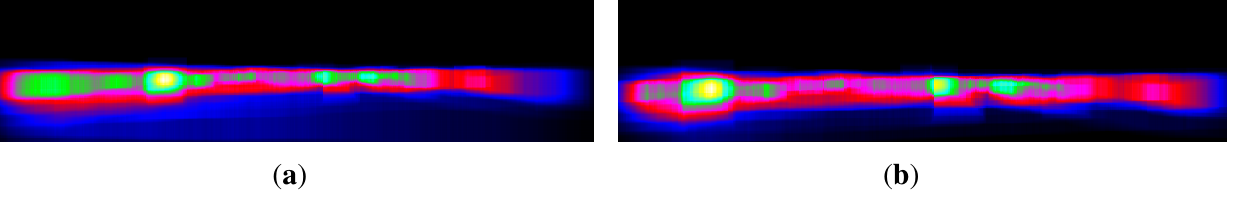
Figure 4. Heat map of training for the RIFIR dataset: ( a ) visible; ( b )